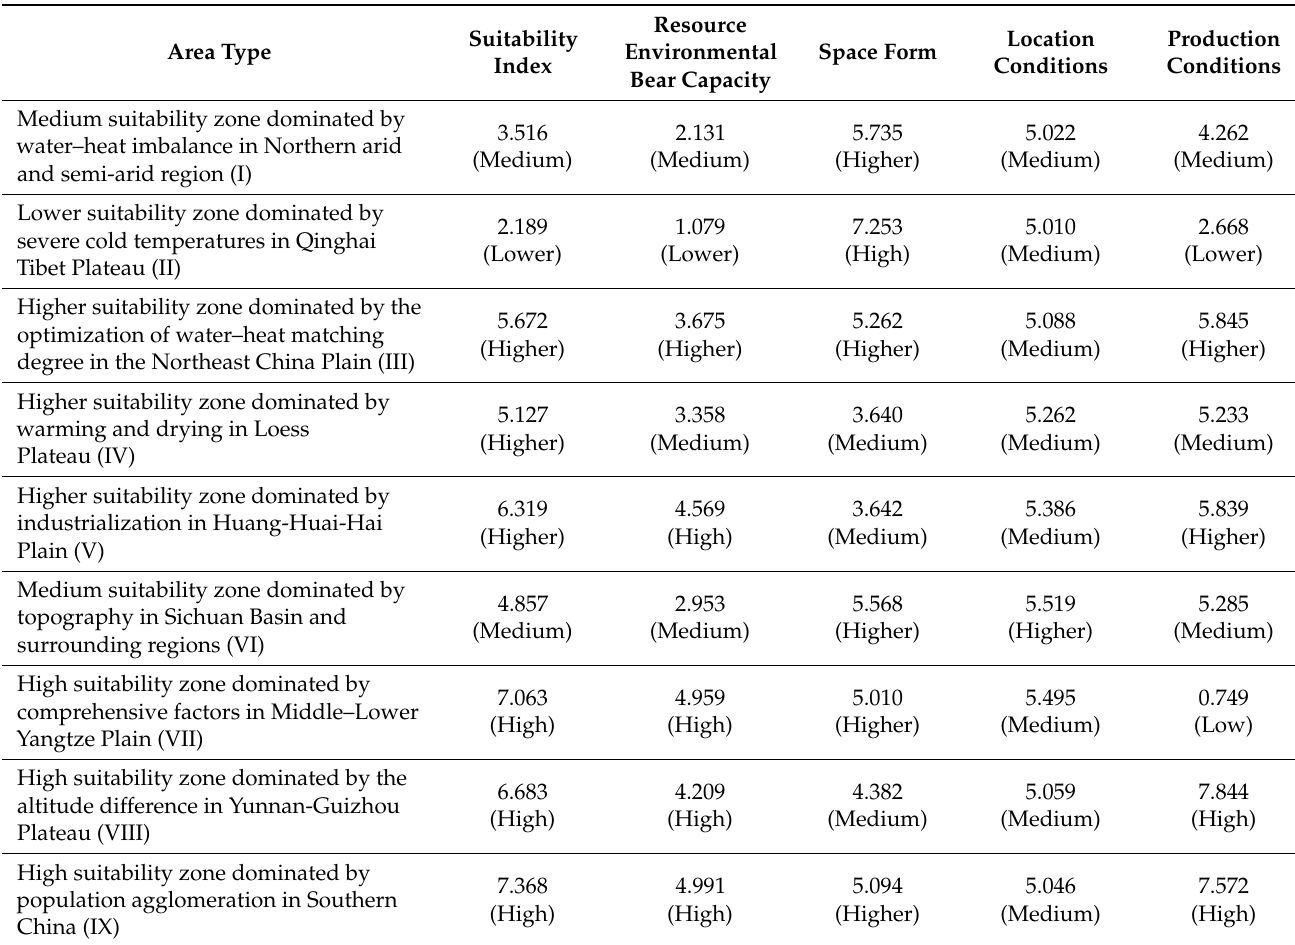
Table 5. Mathematical characteristics of spatial suitability of agricultural production in nine agricul- tural area in